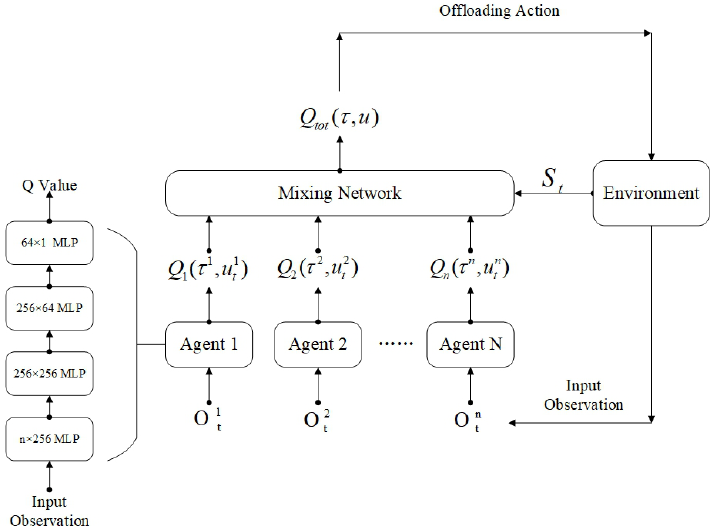
Figure 3. Schematic diagram of MACA network architecture. The Q-network of each agent contains [256, 256, 64] hidden layers, introducing a double Q-network and dueling Q-network. The global state information is added to the mixing network, and the global reward is monotonically decomposed into the local reward of each